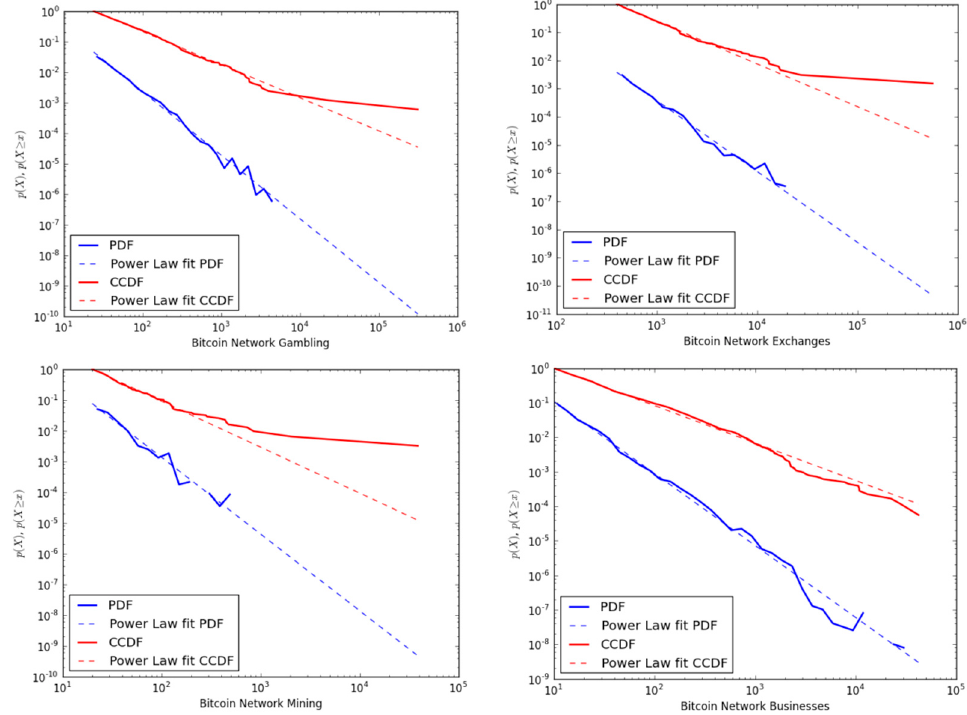
Figure 23. Degree Distribution (PDF, CCDF) for different Business Categories.